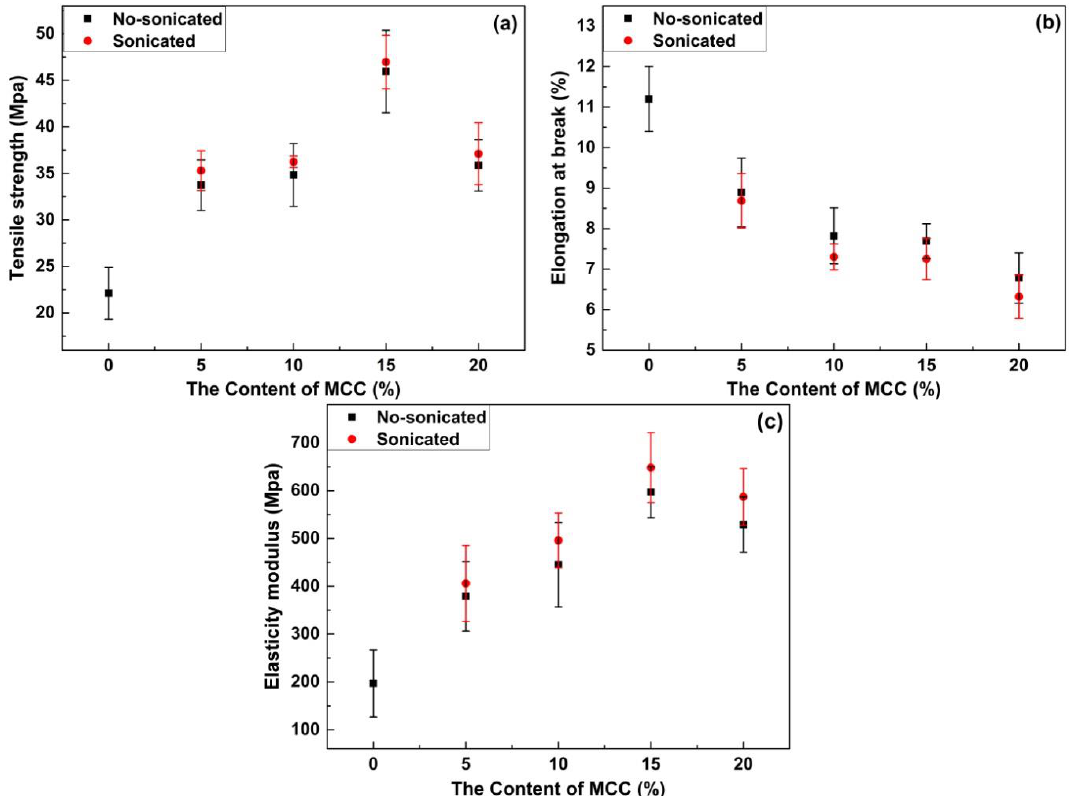
Table 4. The tensile strength, elongation at break, and elasticity modulus tensile strength of pure fish glue film and composite films.